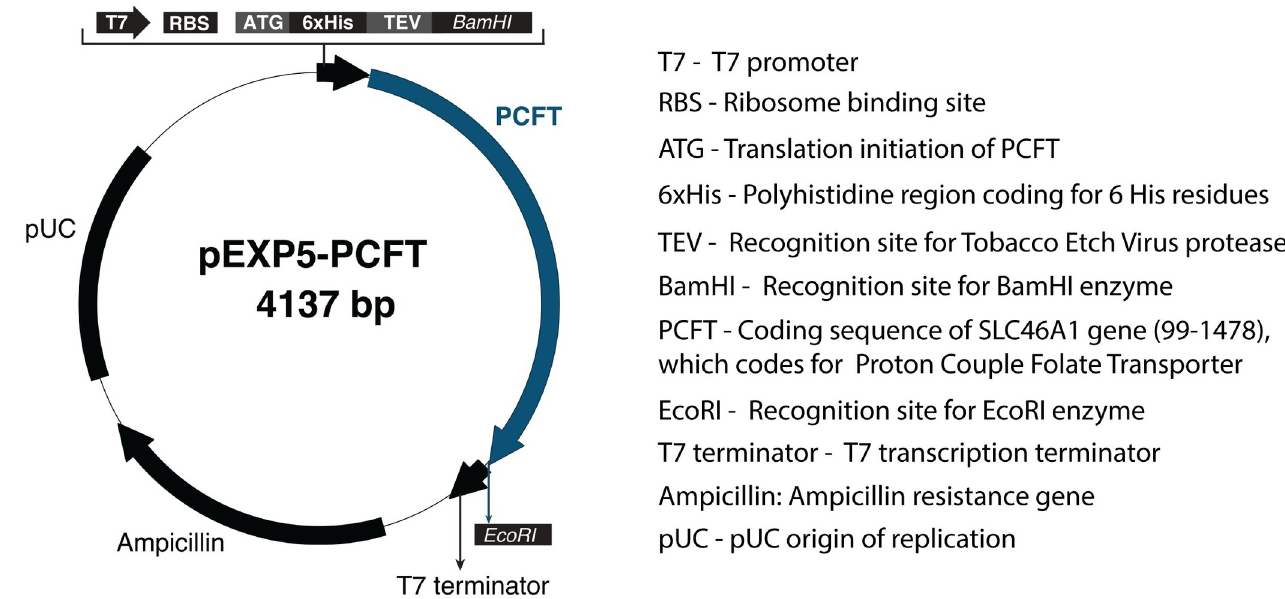
Fig 1. PCFT expression plasmid. The coding sequence of SLC46A1 gene, nucleotides from 99 to 1478, together with two recognition sites for BamHI and EcoRI restriction enzymes, were cloned into pEXP5-NT/TOPO vector purchased from ThermoFisher Scientific. The correct DNA sequence of the PCFT construct was confirmed by